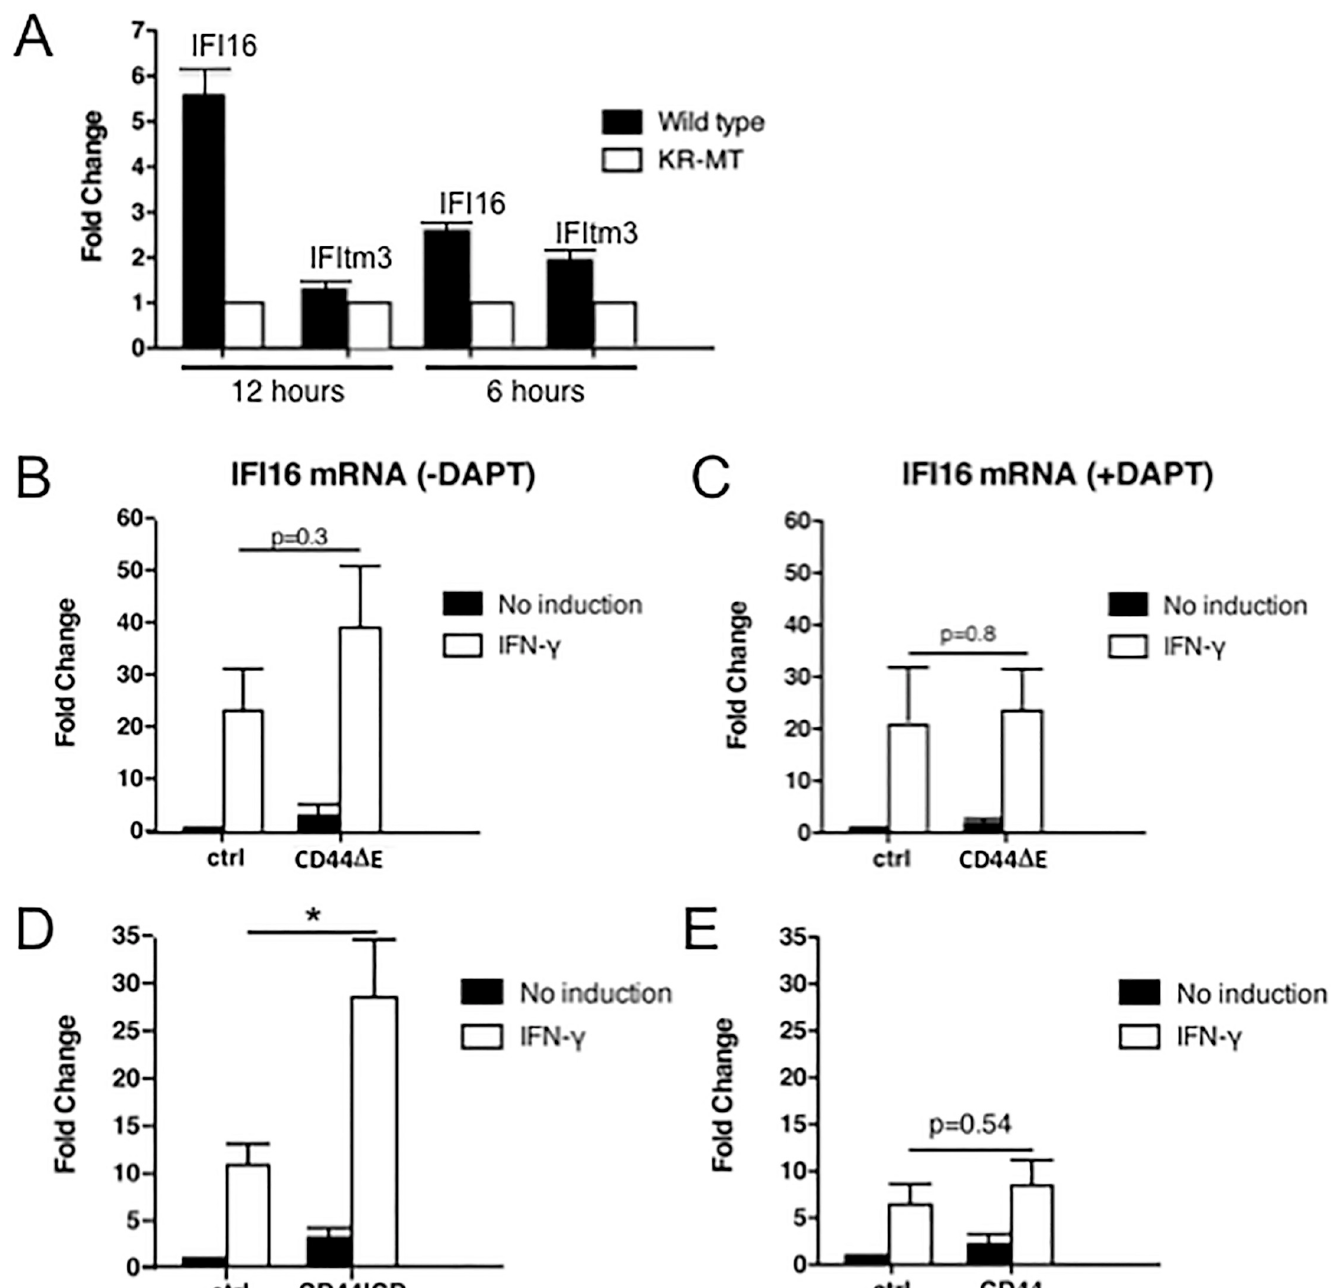
Fig 2. CD44 cleavage is required for IFN- γ -induced expression of IFI16. (A ) RPM-MC cells were transfected either with full-length CD44WT or CD44-KR-MT, serum starved O/N and subsequently treated with 100ng/ml TPA for 30 min. After additional 12 or 6 hrs of cultivation in serum-free medium, total RNA was isolated and used for RT-qPCR. Similar results were obtained in 3 separate experiments (IFI16: interferon-inducible protein 16: IFItm3: interferon-inducible transmembrane protein 3). ( B-E ) RPM-MC cells were seeded in 6 cm dishes at a cell density of 3x10 5 cells/dish. 24 h after seeding, cells were transiently transfected with either a control vector or with vectors expressing either CD44 Δ E (mimicking the product of ADAM cleavage, which serves as substrate for γ -secretase), CD44-ICD or CD44 full length. For cell recovery, medium was changed after 14 h. Subsequently, cells were stimulated with 100 ng/ml IFN- γ for 6 h. RNA was isolated and transcribed into cDNA. cDNA was analysed by RT-qPCR using primers for human IFI16 (primers 9 and 10, Table 1) and actin for normalization (primers 7 and 8, Table 1). In Fig 2C γ -Secretase activity was blocked by 5 μ M DAPT O/N prior to IFN- γ treatment. All experiments were done in triplicates. For statistical analysis see Materials and